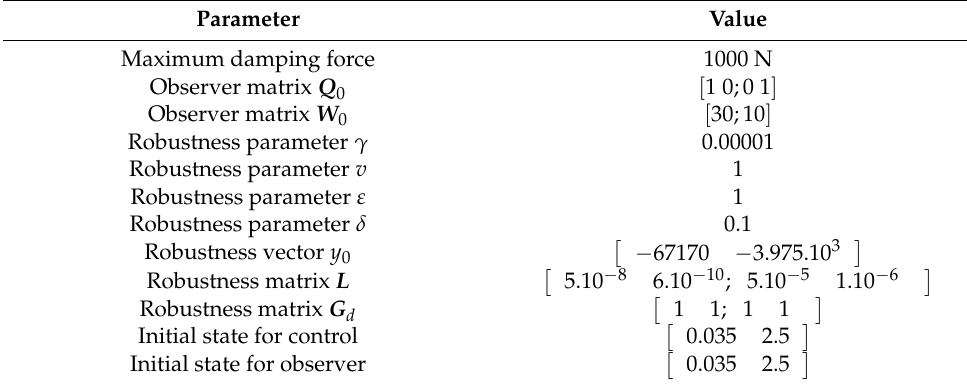
Table 3. Parameters of the seat suspension for Compared Controller 2